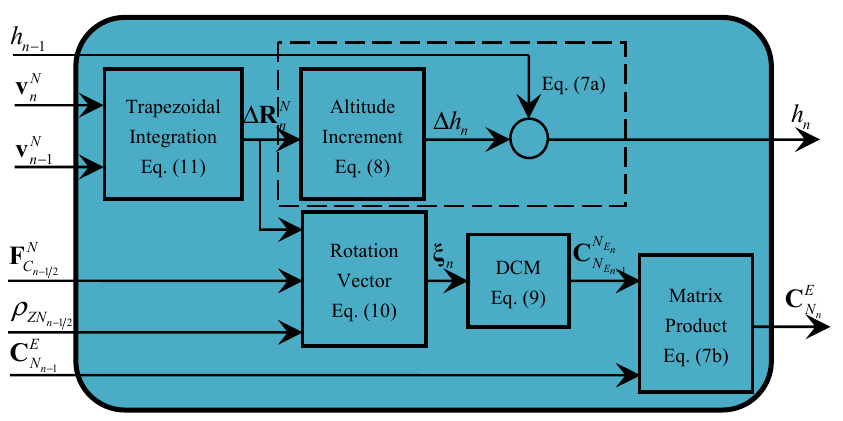
Figure 8. Diagram of module